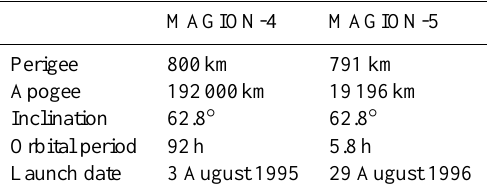
Fig. 1. The MAGION-5 flight model assembled and tested in the laboratories of the Institute of Atmospheric Physics, Prague, dur- ing winter-spring 1996 and launched on 29 August 1996 as part of the INTERBALL mission. The solar array is shown in the fully deployed position. The MAGION-4 configuration was almost iden- tical. Table 2. Initial orbital parameters.